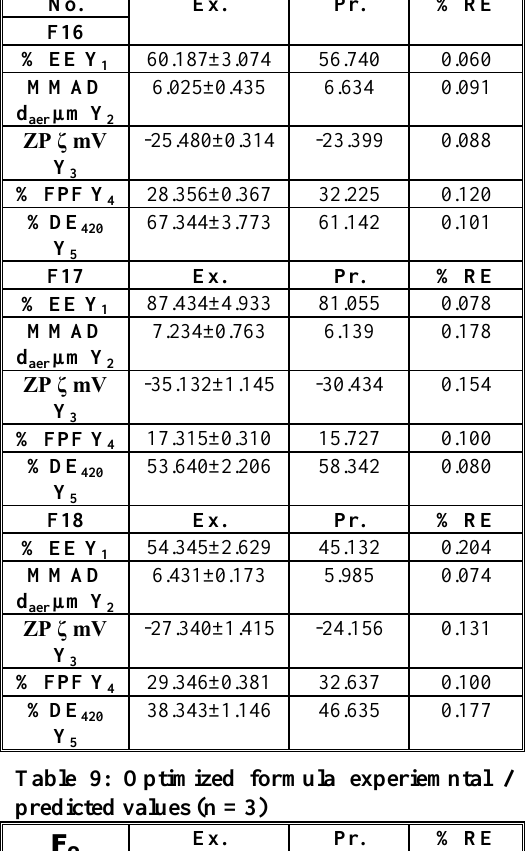
Table 10: Release kinetic parameters of the